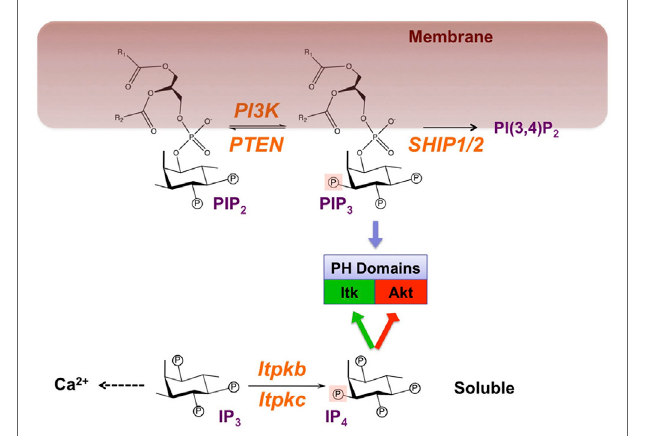
FigURe 1 | Symmetric signaling by phosphoinositide 3 kinase (PI3K) and Itpkb controls effector recruitment through the analogous but phase-separated pleckstrin homology (PH) domain ligands PIP 3 and IP 4 . Engagement of antigen receptors activates PI3K, which phosphorylates the membrane-lipid phosphatidylinositol(4,5) bisphosphate (PIP 2 ) on the 3-position of its cytoplasm-exposed inositol ring to generate phosphatidylinositol(3,4,5) trisphosphate (PIP 3 ). Alternatively but not shown to emphasize the PI3K/Itpkb symmetry, phospholipase-C γ 1 (PLC γ 1) can hydrolyze PIP 2 into the second messengers diacylglycerol (DAG) and soluble inositol(1,4,5) trisphosphate (IP 3 ). Canonically, PIP 3 accumulation is limited through its removal by two families of phospholipid phosphatases: Phosphatase and tensin homolog (PTEN) which reverses the PI3K reaction, and SH2 domain-containing inositol polyphosphate-5-phosphatases (SHIP-1/2) which convert PIP 3 into phospatidylinositol(3,4) bisphosphate [PI(3,4)P 2 ]. Mainly through their IP headgroups, PIP 2 , PIP 3 , and PI(3,4)P 2 can bind to PH and other domains in signaling proteins such as Itk and Akt,